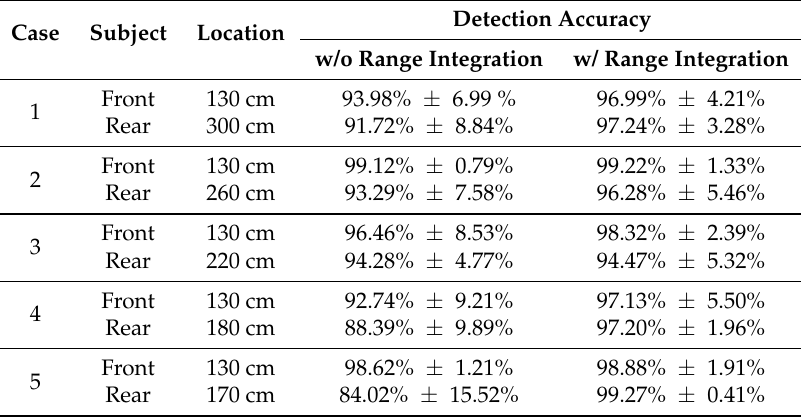
Table 1. Repeatability test of detection accuracy for vital